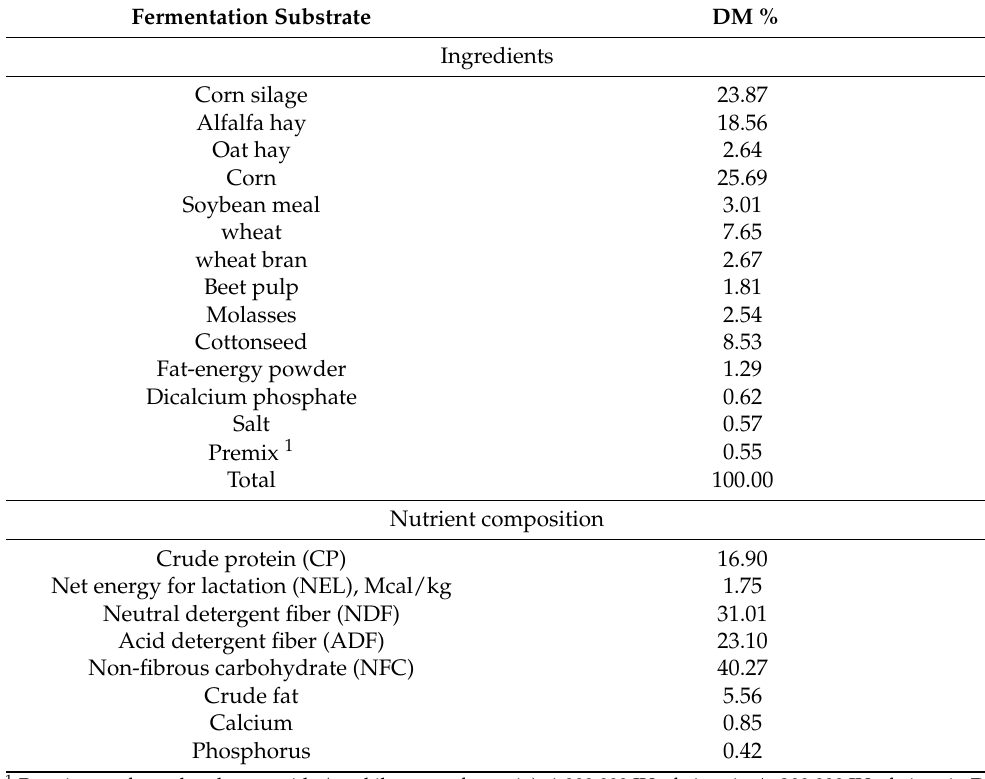
Table 1. Ingredients and nutrient composition of the fermentation substrate (Dry matter basis, DM %). Fermentation